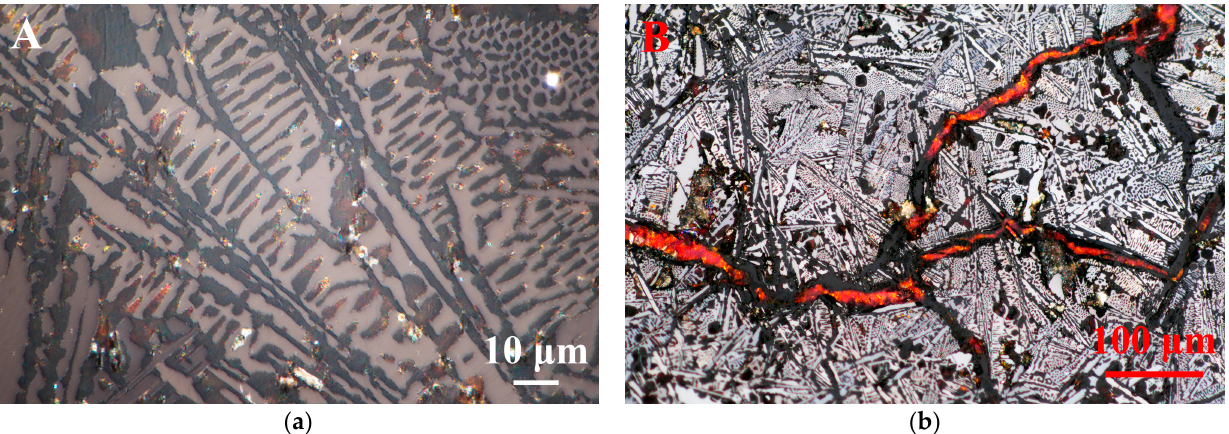
Figure 3. Metallographic diagrams of an archaeological iron artifact from the Nanhai I. Primary cementite and eutectic ledeburite ( a ); cracks of the iron ( b ).